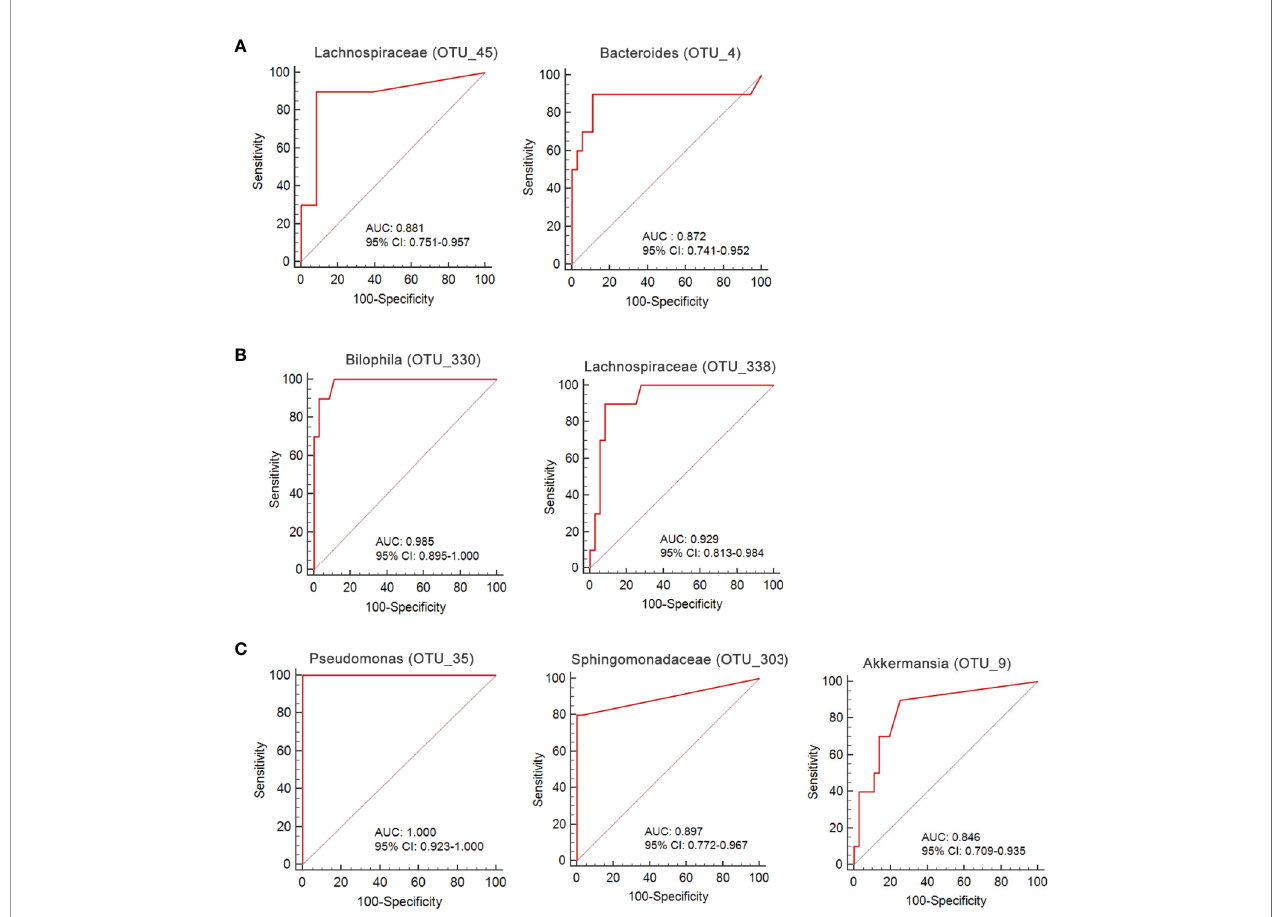
FIGURE 8 | ROC curves for the OTU-based diagnostic biomarkers of ischemic stroke. (A) lacunar infarction; (B) non-lacunar acute ischemic infarction; (C) post- ischemic stroke.